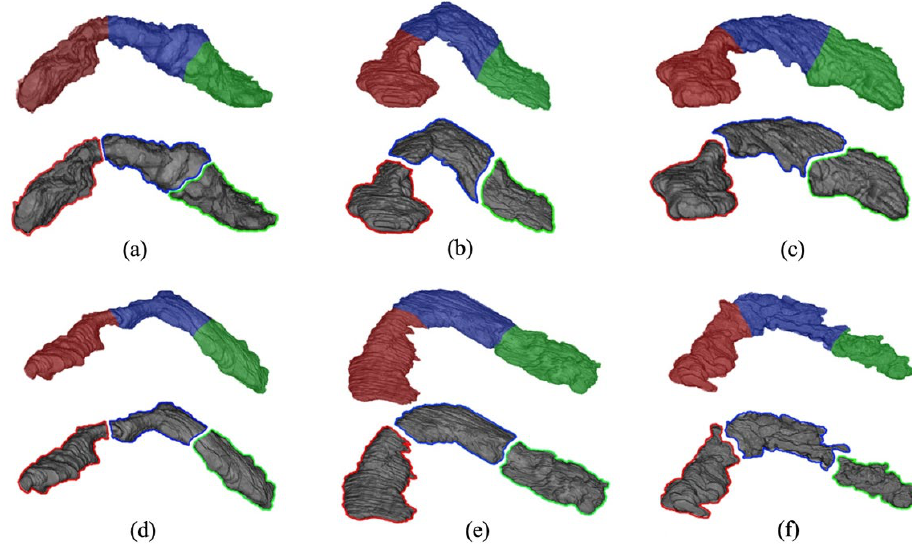
), Blue ( ), Green ( ): Best ( a , d ), Moderate ( b , e ), Worst ( c , f ). Figure 3. Red ( Figure 3. Red ( H ), Blue ( B ), Green ( T ): Best ( a , d ), Moderate ( b , e ), Worst ( c , f 𝐻𝐻 𝐵𝐵 𝑇𝑇 Testing on D 1 and D 2 resulted in a mean overall DSC of 95.6% and 89.9%, respectively.